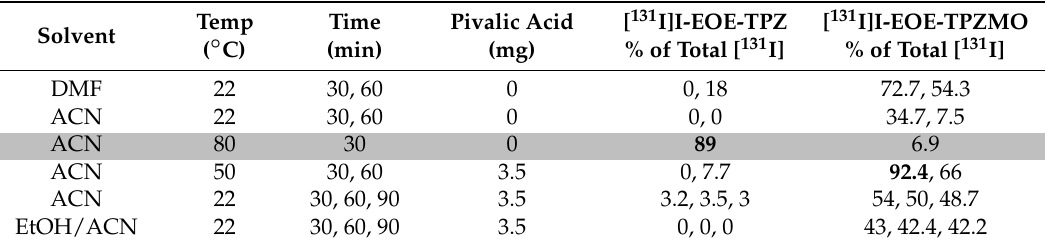
Figure 3. RTLC of the reaction mixture following [ 131 I]iodide exchange on P2 at 22 °C. [ 131 I]I-EOE-TPZMO is the main product by 30 min ( A ), [ 131 I]I-EOE-TPZ is evident in low radiochemical yield (18%) at 60 min ( B ). Table 2. Radioiodination conditions and product yields for [ 131 I]iodide exchange on P2 .